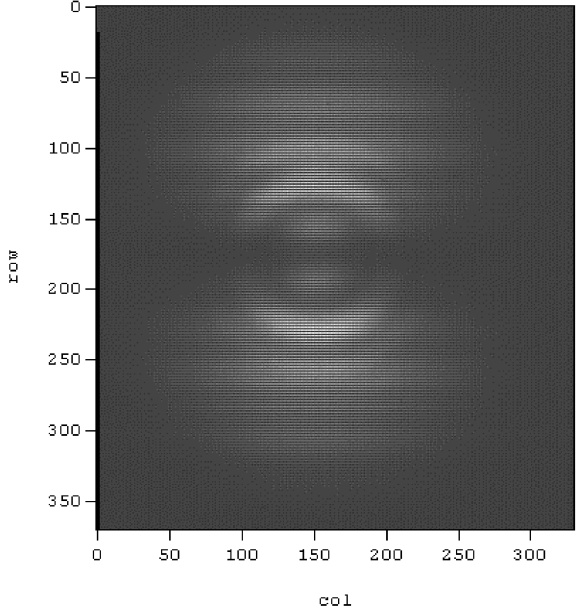
FIG. 5. Whole-beam polarized OTR interference